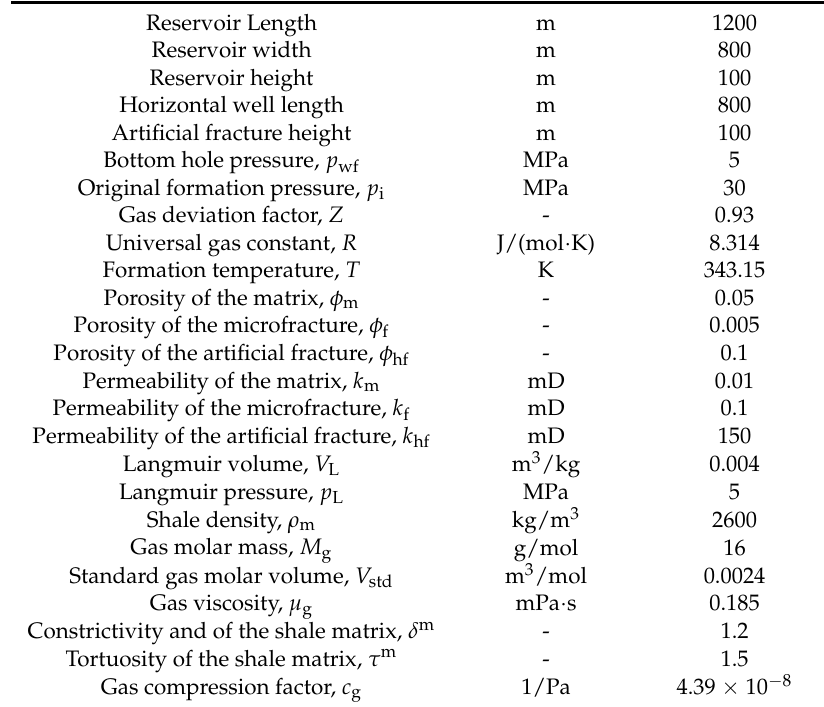
Table 3. The parameter set for the shale gas reservoir model.